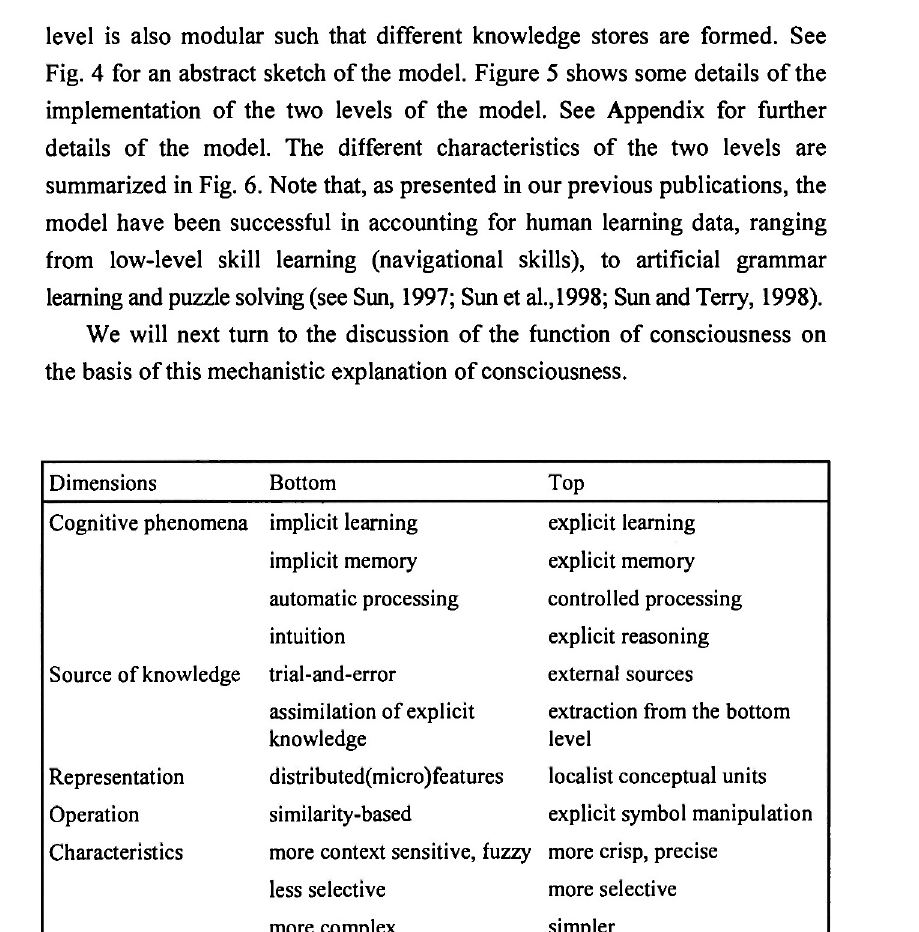
Fig. 6: Comparison of the two levels of the CLARION